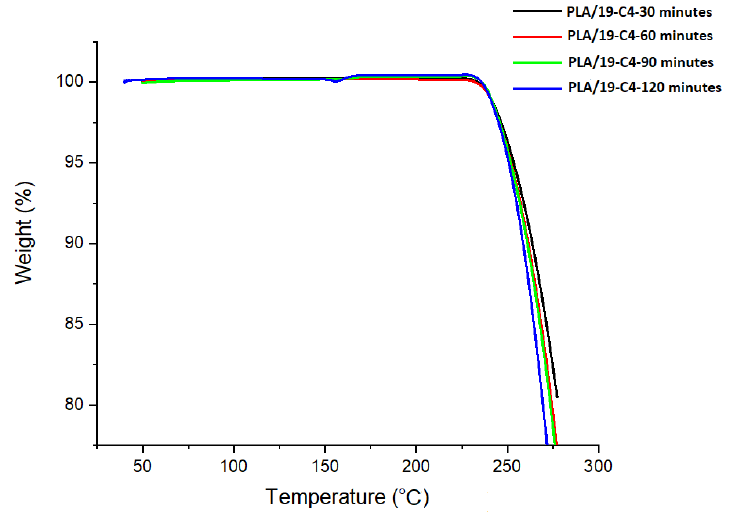
Figure 11. TGA analysis of PLA-19/C4 electrospun fibers. Figure 11. TGA a nalysis of PLA - 19/C4 electrospun fibers .